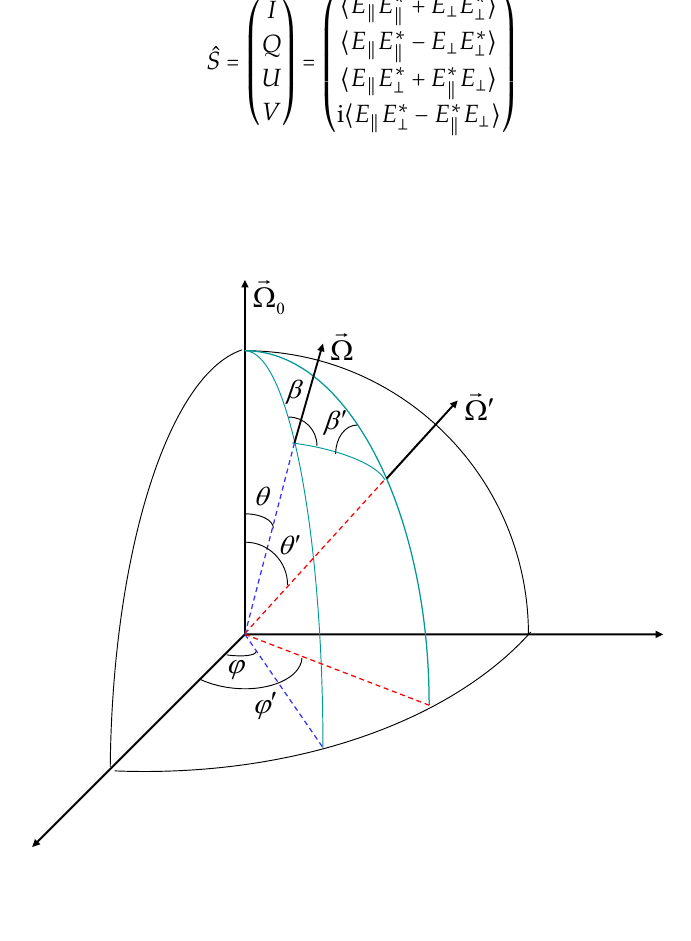
Figure 1. Scattering